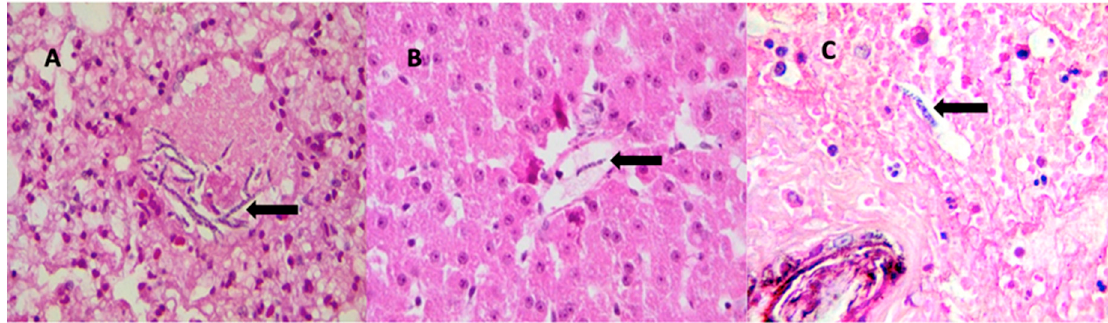
Figure 3. Mf in blood vessels of ( A ) lung, ( B ) liver, and ( C ) skin. Black arrows indicate microfilariae.